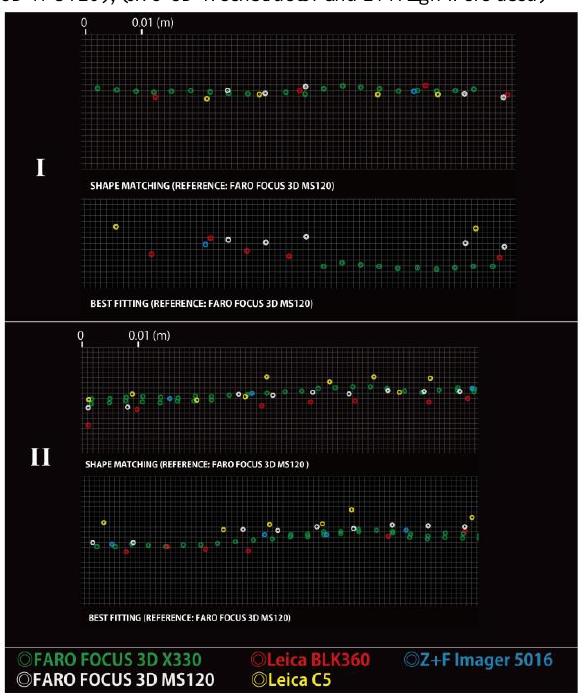
Figure 7: Alignments of Point Clouds (Refference:FARO Focus 3D MS120)